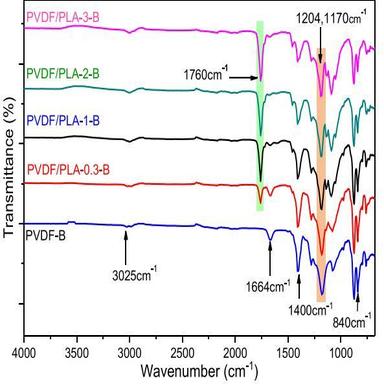
FTIR spectra of PVDF membranes modified by PLA at different PLA/